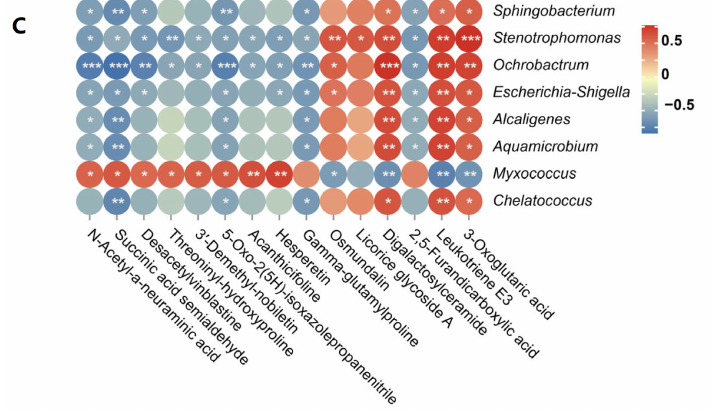
Figure 7. Spearman’s correlation heatmap. ( A ) Correlation analysis between significantly differen- tial milk phenotype parameters and differentially abundant milk bacterial taxa at the genus level; ( B ) Correlation analysis between significantly differential milk phenotype parameters and dif- ferentially expressed metabolites; ( C ) Correlation analysis between differentially abundant milk bacterial taxa at the genus level and differentially expressed metabolites. IL-1 β , interleukin-1 β , IL-6, interleukin-6; DPPH, 1,1-Diphenyl-2-picrylhydrazyl radical; MDA, malondialdehyde; LZM, lysozyme; SCC, somatic cell count. * p < 0.05, ** p < 0.01, *** p <